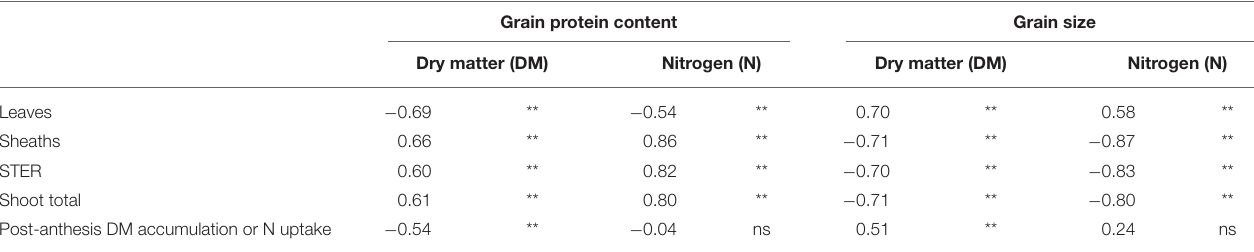
TABLE 5 | Pearson’s correlation coefficient of grain protein content and grain size with the translocation of DM and N accumulation in leaves, sheaths and STER from pre-anthesis, and assimilation and N accumulation from post-anthesis among the 23 spring malting barley varieties under recommended N fertilization conditions across 2